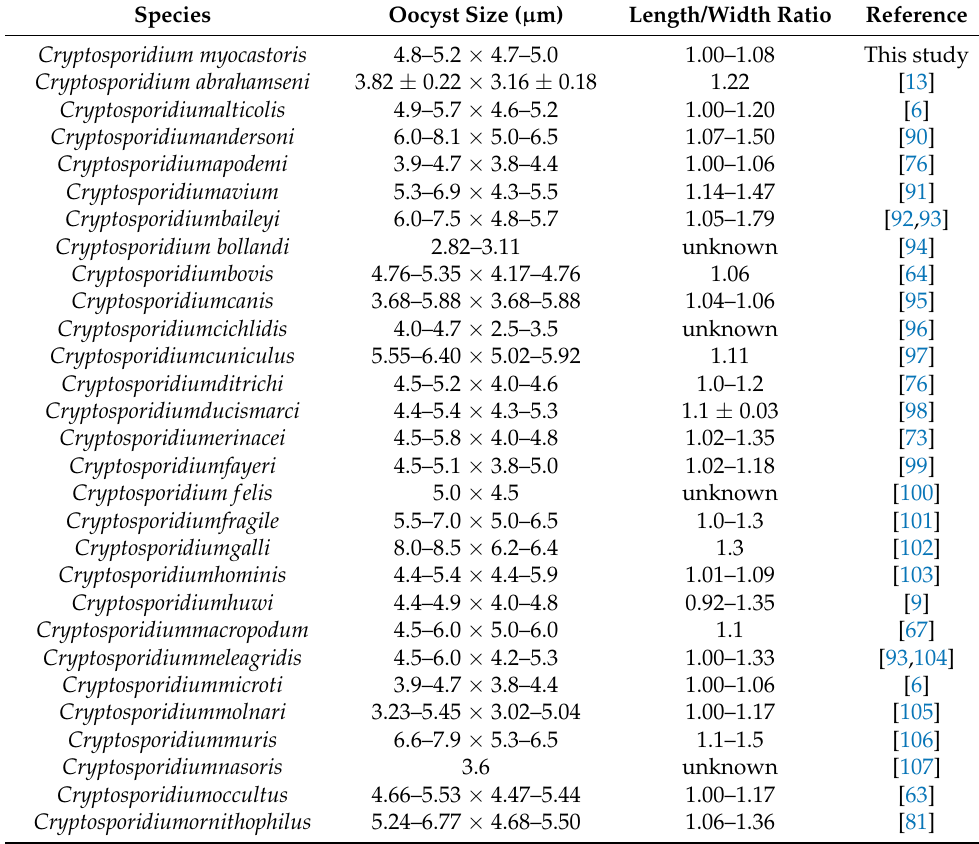
Table A1. Oocyst sizes of valid species of the genus Cryptosporidium